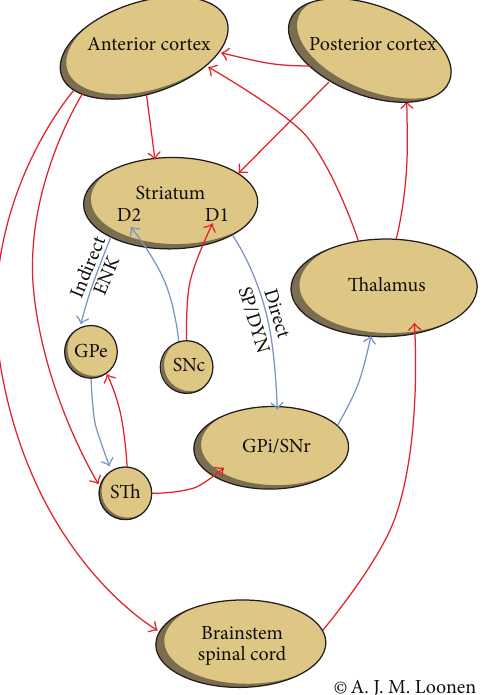
Figure 1: The cortico-striatal-thalamic-cortical circuits, including the indirect and direct pathways; ENK = enkephalin; GPe = globus pallidus, external segment; GPi = globus pallidus, internal segment; SNc = substantia nigra, pars compacta; SNr = substantia nigra, pars reticulata; SP/DYN = substance P/dynorphin; STh = subthalamic nucleus; D1 or D2: medium-sized spiny neurons with D1 or D2